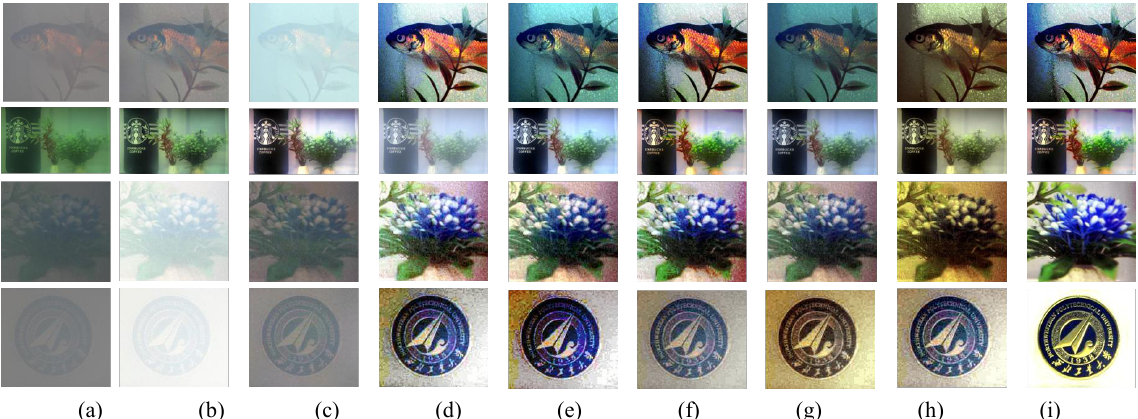
Figure 3. Underwater image enhancement results of different scenes (a)Original (b)CLAHE (c)GC (d) HE (e)ICM (f)RD